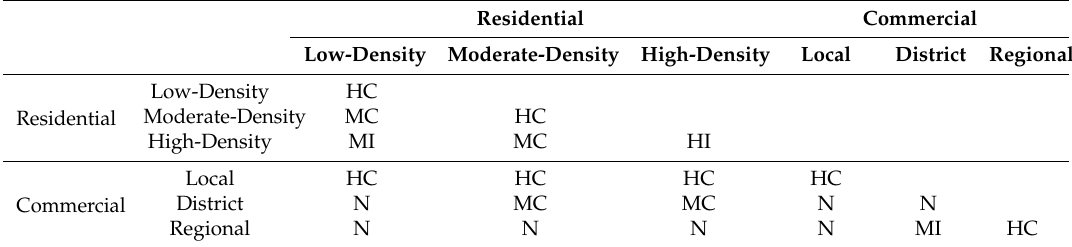
Table 2. A part of the compatibility matrix from [21], with linguistic values of compatibility between land-uses, i.e., highly incompatible (HI), moderately incompatible (MI), low/neutrally compatible (NC), moderately compatible (MC), and highly compatible